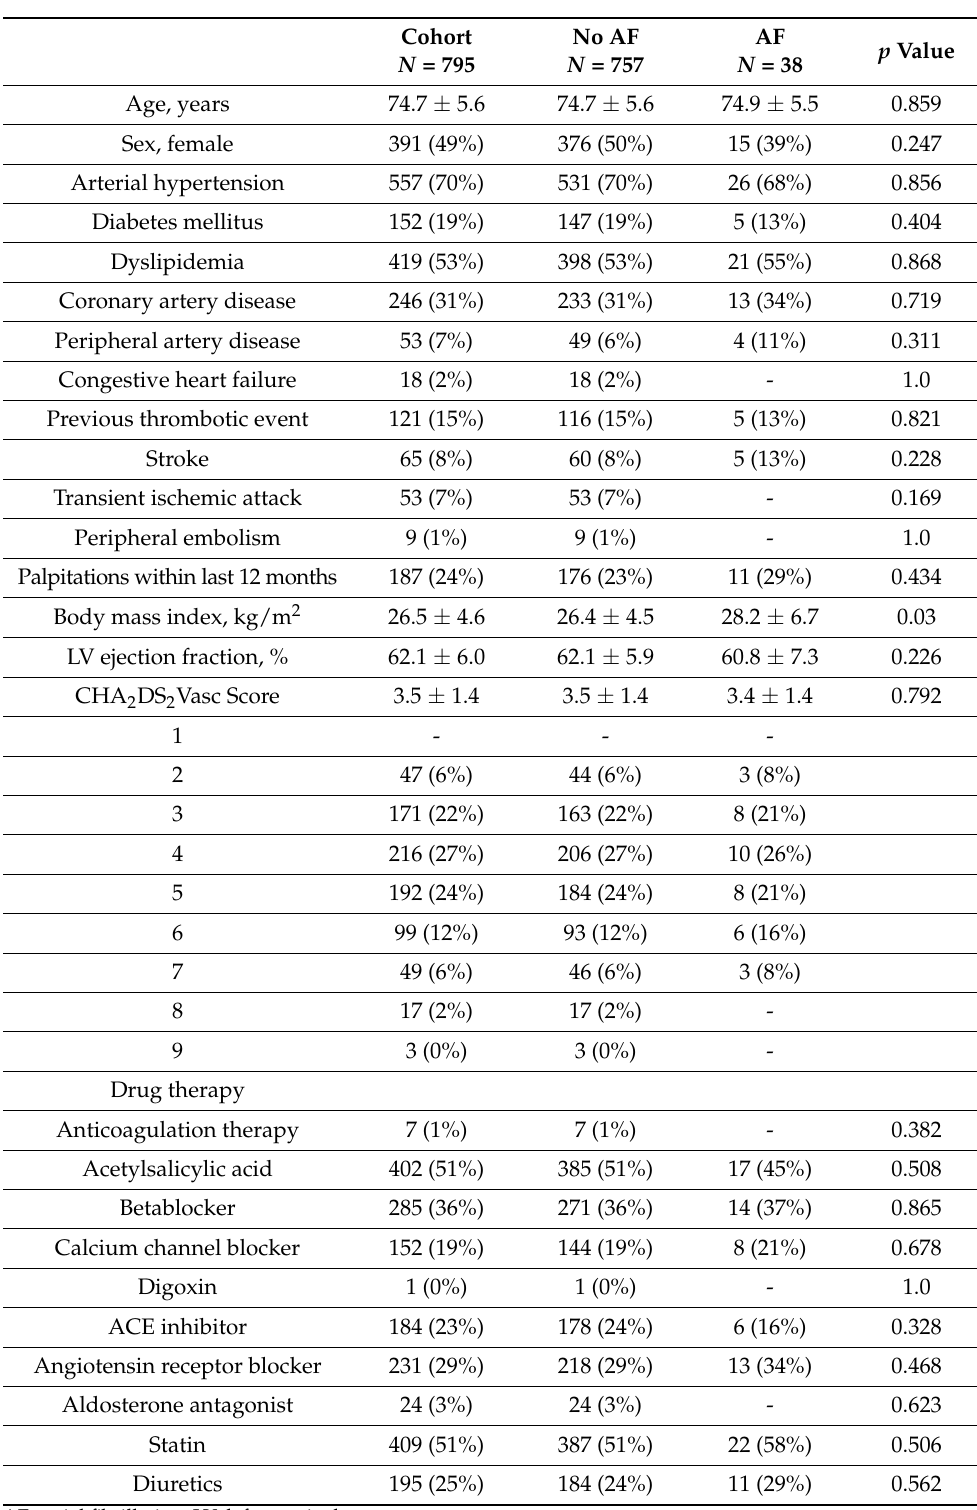
Table 1. Patient